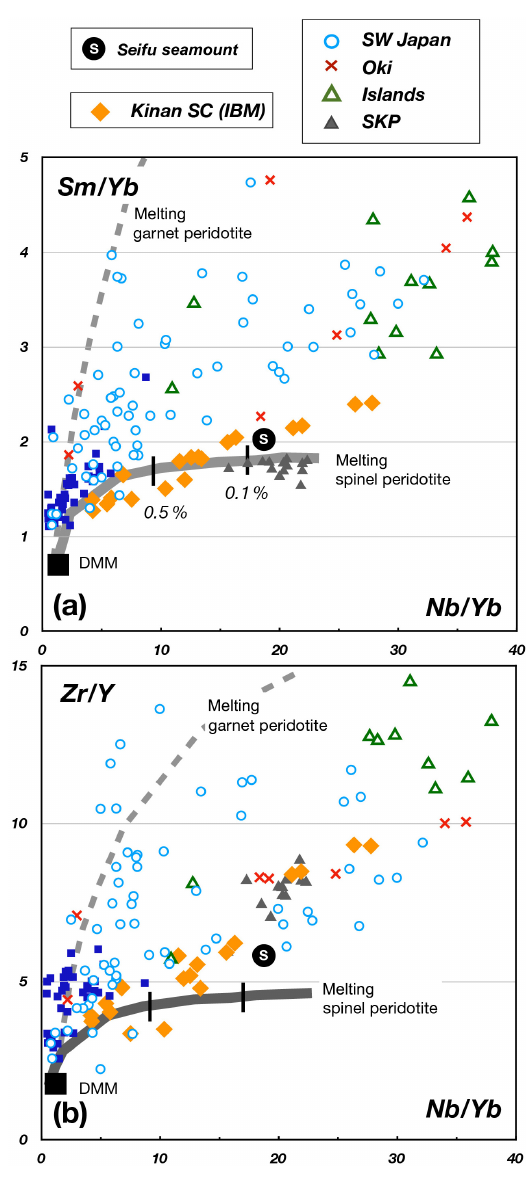
Figure 8. (a) Sm / Yb vs. Nb / Yb. (b) Zr / Y vs. Nb / Yb. Melting trends for garnet and spinel peridotites were calculated from a batch melting model and using the distribution coefficients from Kelemen et al. (2003). The depleted MORB mantle (DMM) composition is from Workman and Hart (2005). The southwestern Japan data are from San-yo, San-in, and northwest Kyushu (see Fig. 3 for the data sources).